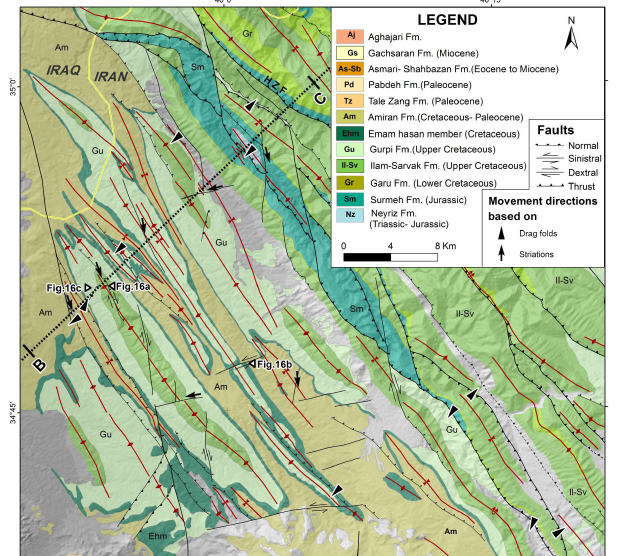
Figure 2. Geological map of the Zagros collision zone in the Kurdistan area (NW Iran). Rectangles show the location of the Kermanshah–Sulaimani area (Fig. 7) and Salas area (Fig. 15). The dotted line (A to F) is the trace of the regional cross section shown in Fig. 6. For the location of the area within the Zagros collision zone as well as the fault names, refer to captions of Fig.